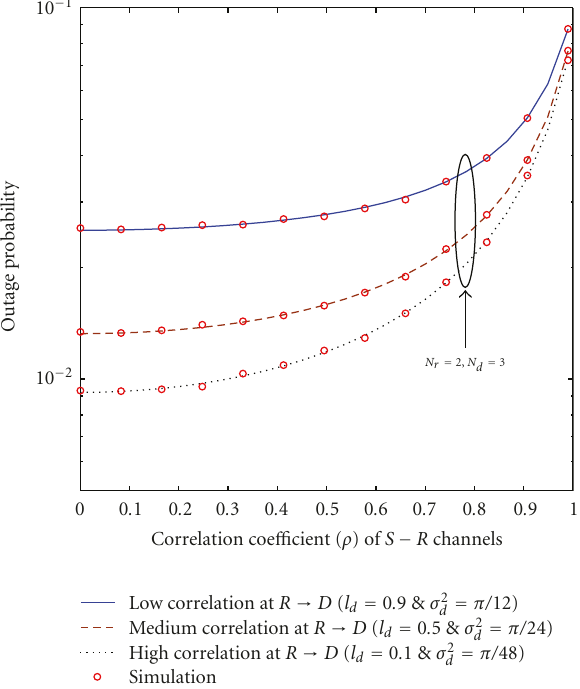
= π/ 12) Low correlation at R → D ( l d = 0 . 9 & σ 2 d = π/ 24) Medium correlation at R → D ( l d = 0 . 5 & σ 2 d = π/ 48) High correlation at R → D ( l d = 0 . 1 & σ 2 d Simulation Figure 4: Impact of spatial correlation on the outage probability of = γ dual-hop MIMO relaying. γ / 2 = 10 dB and θ d = π/ 6. 1 2